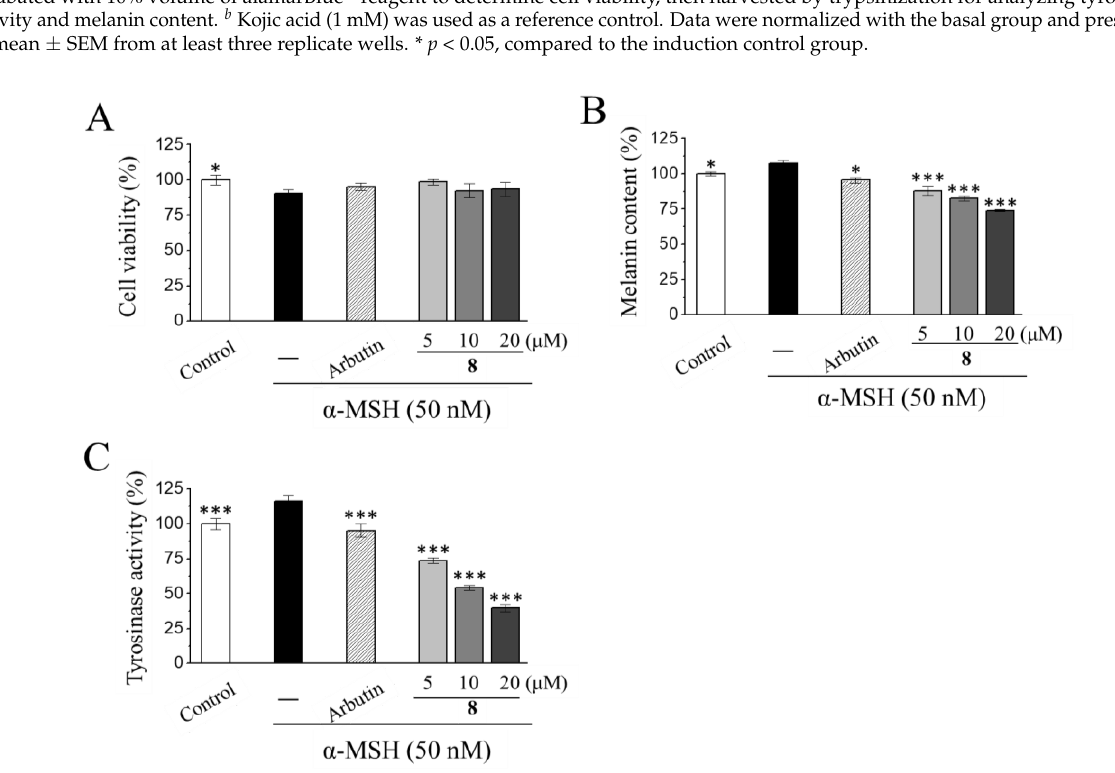
Figure 9. Anti-melanogenic activities of ergosterol peroxide ( 8 ) in murine melanoma B16-F10 cells. Cells were grown with (induction) or without (basal) 50 nM α -melanocyte-stimulating hormone ( α -MSH) for 24 h to induce melanogenesis and then incubated with vehicle control or 5, 10, or 20 µ M of the testing compound for another 48 h. After treatment, cells were incubated with 10% volume of alamarBlue ® reagent to determine cell viability ( A ), then harvested by trypsinization for analyzing the ( B ) melanin content and ( C ) tyrosinase activity. Arbutin (1 µ M) was used as the reference control. Data were normalized with the basal group and presented as mean ± SEM from at least three independent experiments. * p < 0.05. *** p < 0.005, compared to the α -MSH-induction control